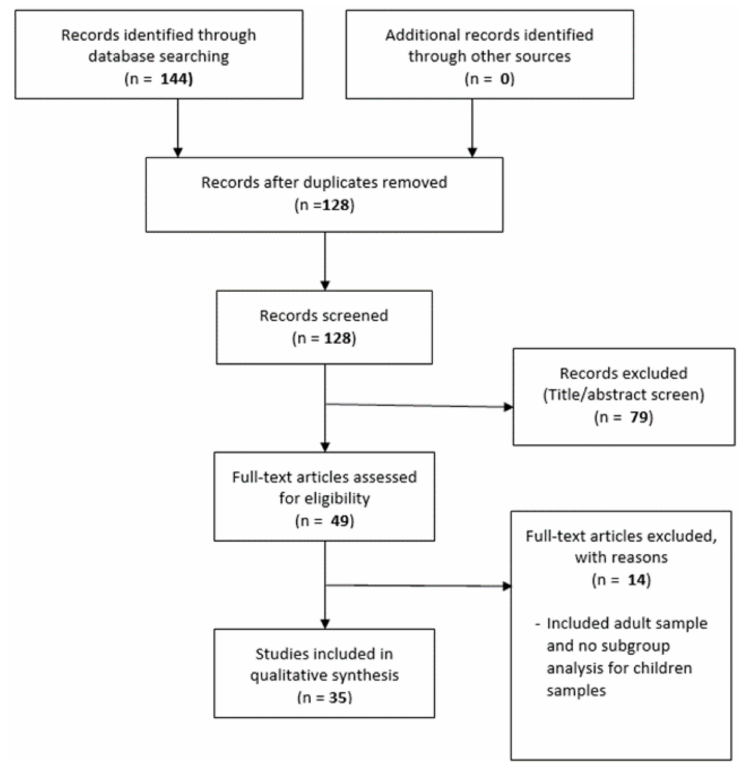
Figure 1. Preferred Reporting Items for Systematic Reviews and Meta-Analyses (PRISMA) flow